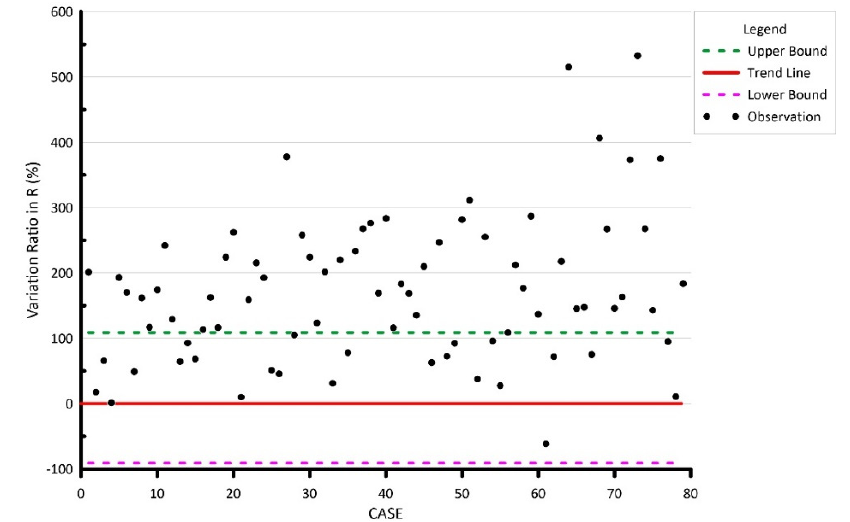
Figure 10. Prediction of rainfall distribution by linear analysis of 79 LSL cases.